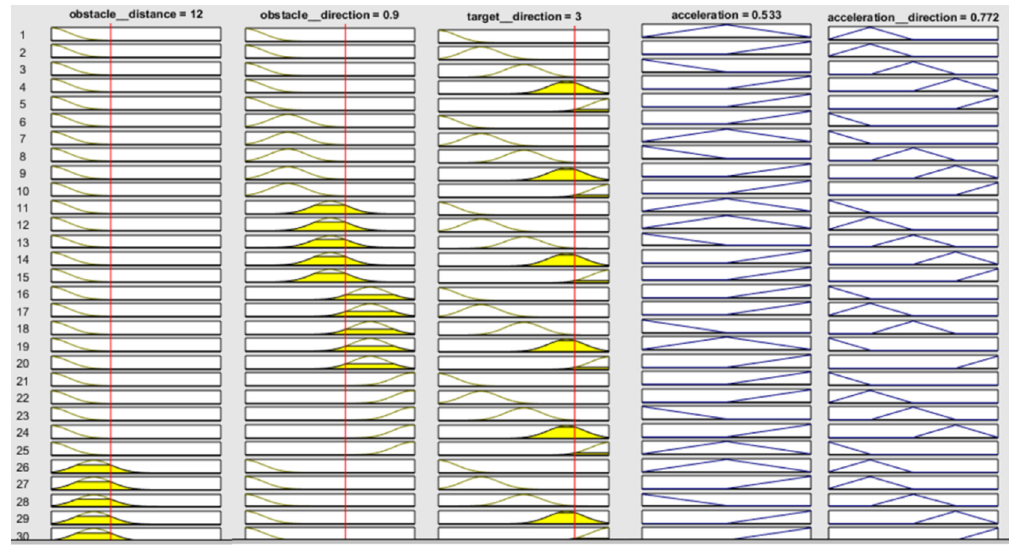
Figure 11. Rule viewer plot.